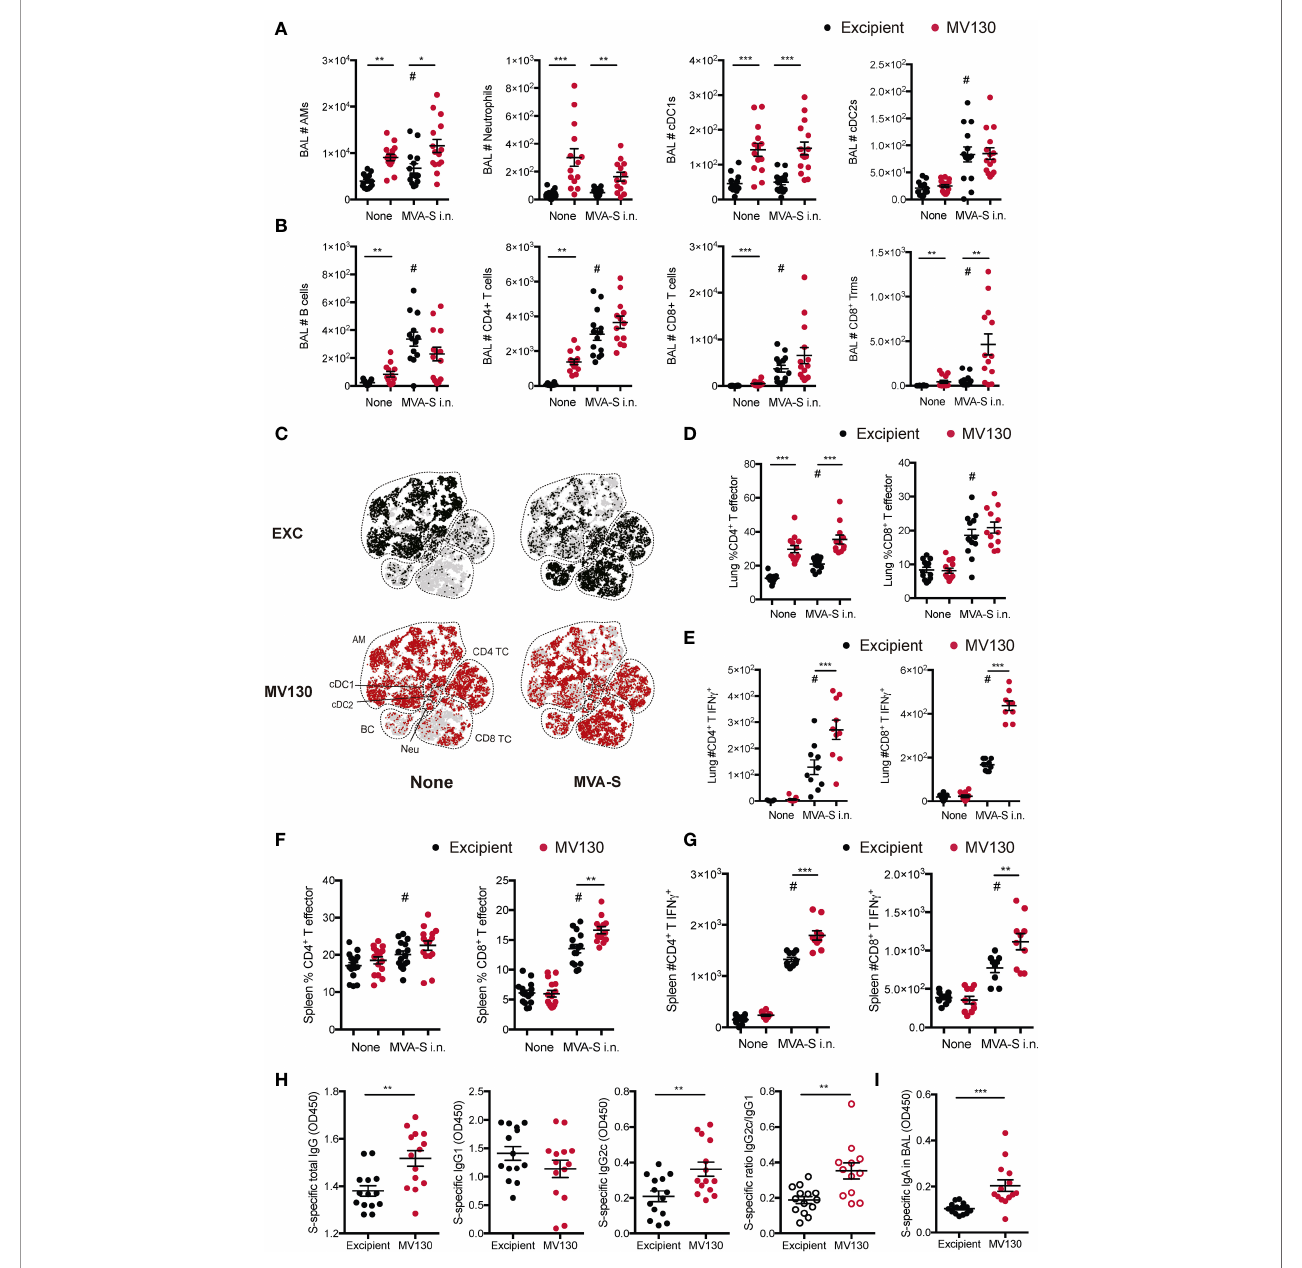
FIGURE 3 | MV130 improves immunogenicity triggered by an MVA-based COVID-19 vaccine candidate after mucosal administration. Three weeks after receiving excipient or MV130 according to Figure 1A , C57BL/6 mice were i.n. vaccinated with a COVID-19 vaccine based on a Modi fi ed Vaccinia virus Ankara (MVA) vector expressing the entire SARS-CoV-2 Spike (S) protein. Samples were collected 10 days later. (A, B) Bronchoalveolar lavage (BAL) was obtained from excipient and MV130-treated mice. Quantitative analysis of different myeloid (A) or lymphoid (B) immune populations identi fi ed by FACS. AMs, alveolar macrophages; cDC1s, type 1 conventional dendritic cells; cDC2s, type 2 conventional dendritic cells. (C) BAL cellular composition was analyzed by t-distributed Stochastic Neighbor Embedding (tSNE) analysis from FACS data. Dotted lines identify speci fi c populations. AM, alveolar macrophages; cDC, conventional Dendritic cells; BC, B cells; Neu, neutrophils; TC, T cell. (D, E) Lungs were recovered, and the effector phenotype (CD44 + ) of CD4 + and CD8 + T cells was analyzed (D) . SARS-CoV-2 S protein-speci fi c activation of CD4 + and CD8 + T cells was assessed by analyzing intracellular IFN g expression by FACS (E) as described in Methods . (F, G) The effector phenotype (F) and SARS-CoV-2 S protein-speci fi c activation (G) of T cells from the spleen were analyzed, as in (D, E) . (H) Levels of SARS-CoV-2 S protein-speci fi c total IgG, IgG1, IgG2c, and the ratio of IgG2c/IgG1 were analyzed in serum of vaccinated mice. Data correspond to values from sera diluted at 1/250. (I) Levels of SARS-CoV-2 S protein-speci fi c mucosal IgA were analyzed in the BAL of vaccinated mice. Data correspond to values from BAL diluted at 1/1. (A, B, D – I) Data shown as mean ± SEM. (A, B, D, H, I) N=3. (E, G) N=2. (A, B, D – I) *p < 0.05; **p < 0.01; ***p < 0.001, Student ’ s t test comparing excipient versus MV130. (A, B, D – I) # p < 0.05 statistical signi fi cance comparing non-vaccinated versus vaccinated conditions. (H, I) OD, optical